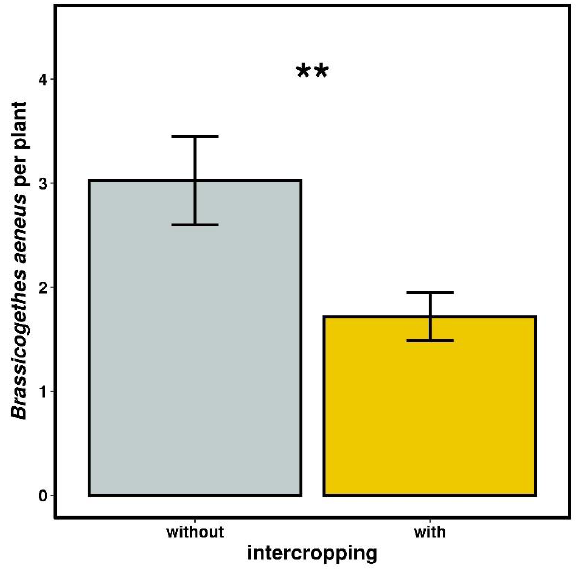
Figure 3. Intercropping Brassica napus reduces the number of Brassicogethes aeneus on flower buds when Vicia faba did not freeze over winter. Average number of B. aeneus per control (gray) and intercropped (yellow) B. napus . Bars represent SEM; ** indicates p -values < 0.01.